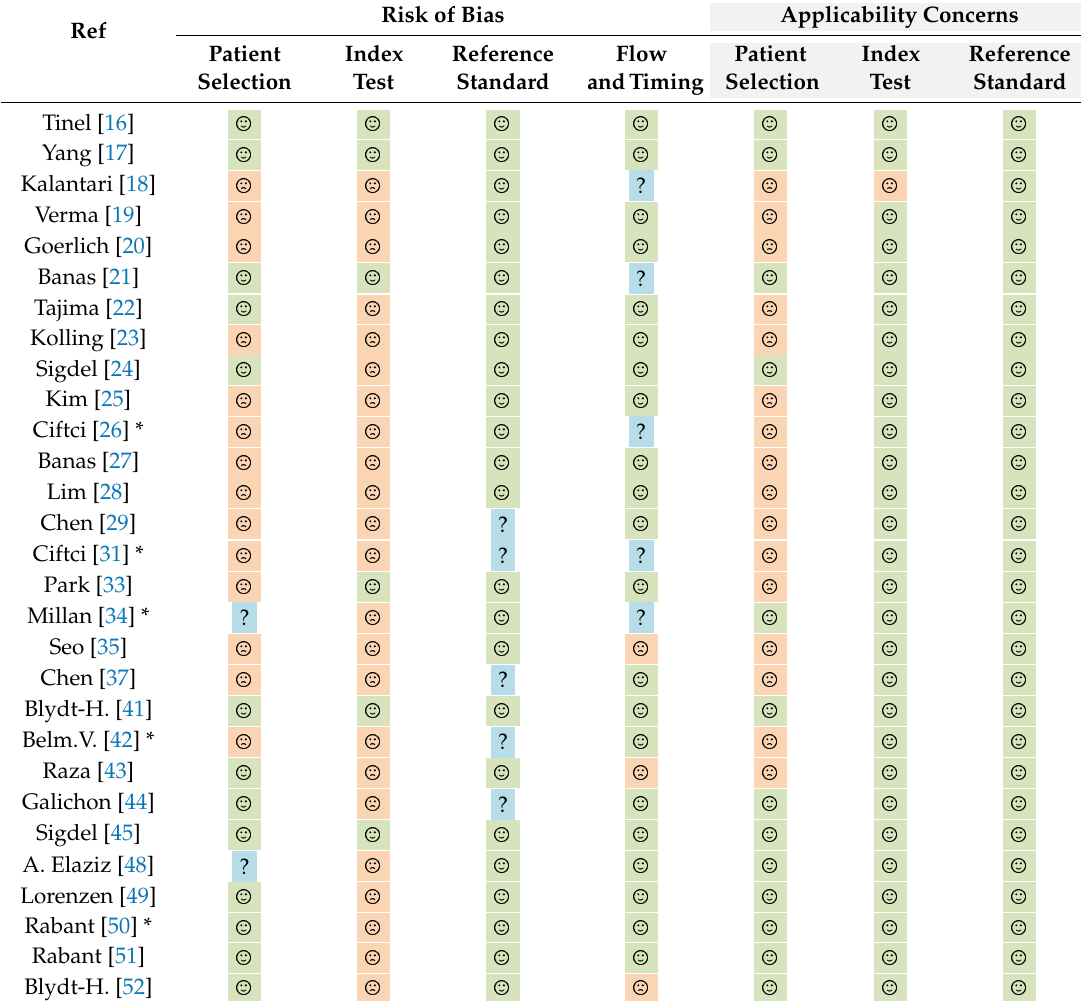
Table 3. QUADAS-2 tool assessment for DTA studies. Table illustrating risk of bias and applicability concerns evaluation as per QUADAS-2 tool for 29 studies providing diagnostic test accuracy data. Risk of Bias Applicability